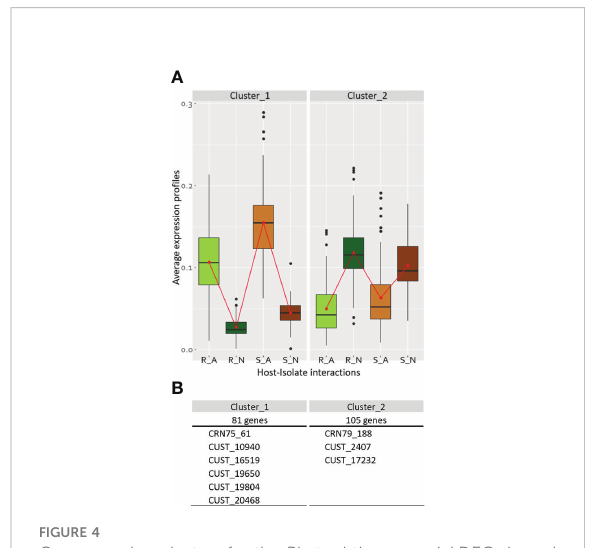
FIGURE 4 Co-expression clusters for the Phytophthora capsici DEGs issued from the interaction-related contrasts. For each cluster, are indicated (A) the average expression pro fi les of the four host- isolate interactions, and (B) the size of co-expression clusters with the list of included CRN and RxLR (CUST) genes within the cluster. Data results from the analysis of the 450 differentially expressed genes (DEGs) from the union of the four interaction- related